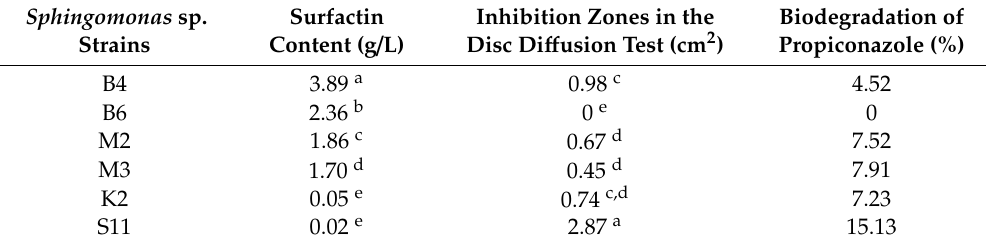
Table 2. Activity of bacterial isolates: biodegradation of propiconazole and surfactin production. Sphingomonas sp.